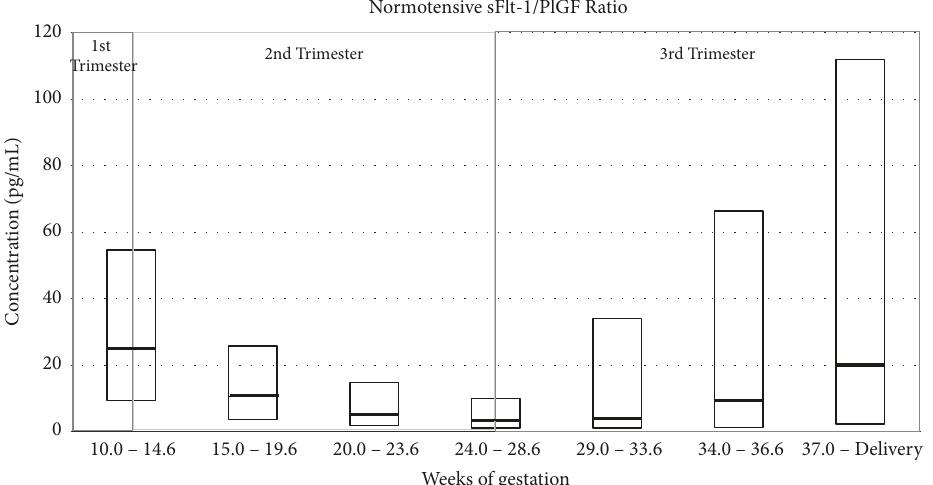
Figure 8: PlGF to sFlt-1 ratio (pg/mL) measured in normotensive women during different weeks of gestation (based on data from Roche Study no. CIM